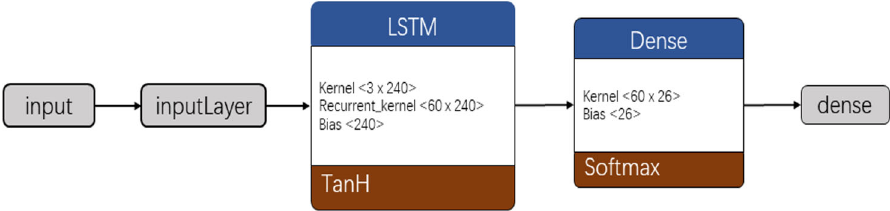
Figure 5. LSTM structure implemented for character recognition.